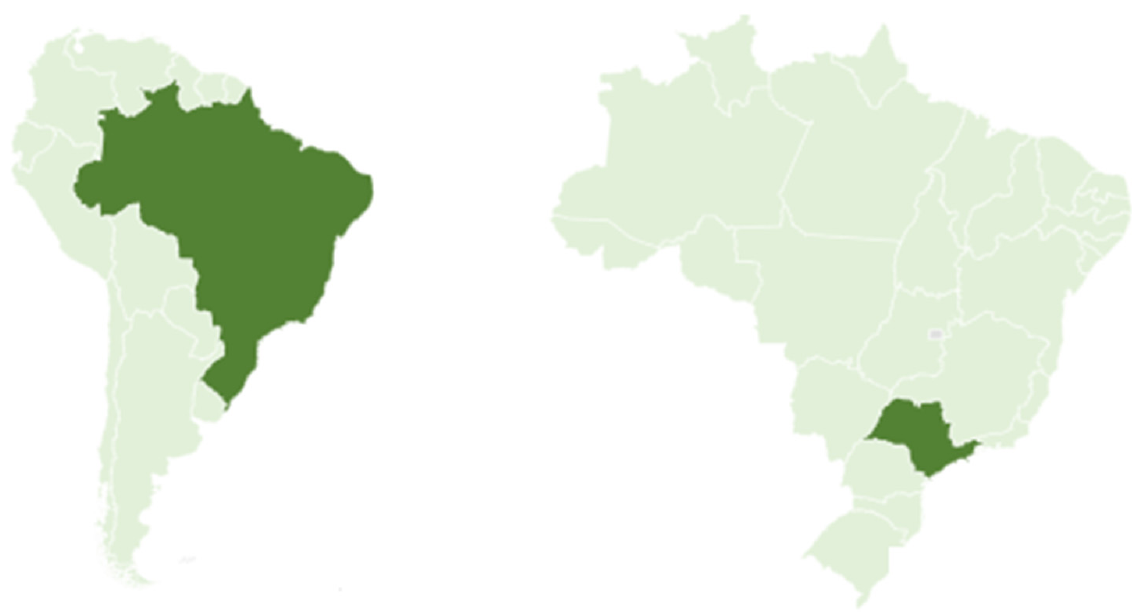
Figure 2. Brazil and São Paulo state location.